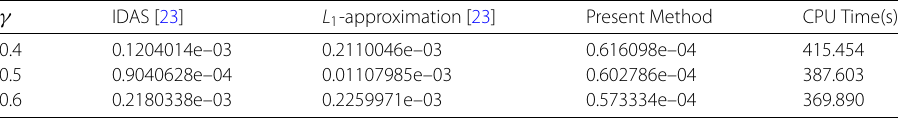
, h = 1 for Example 3 1024 32